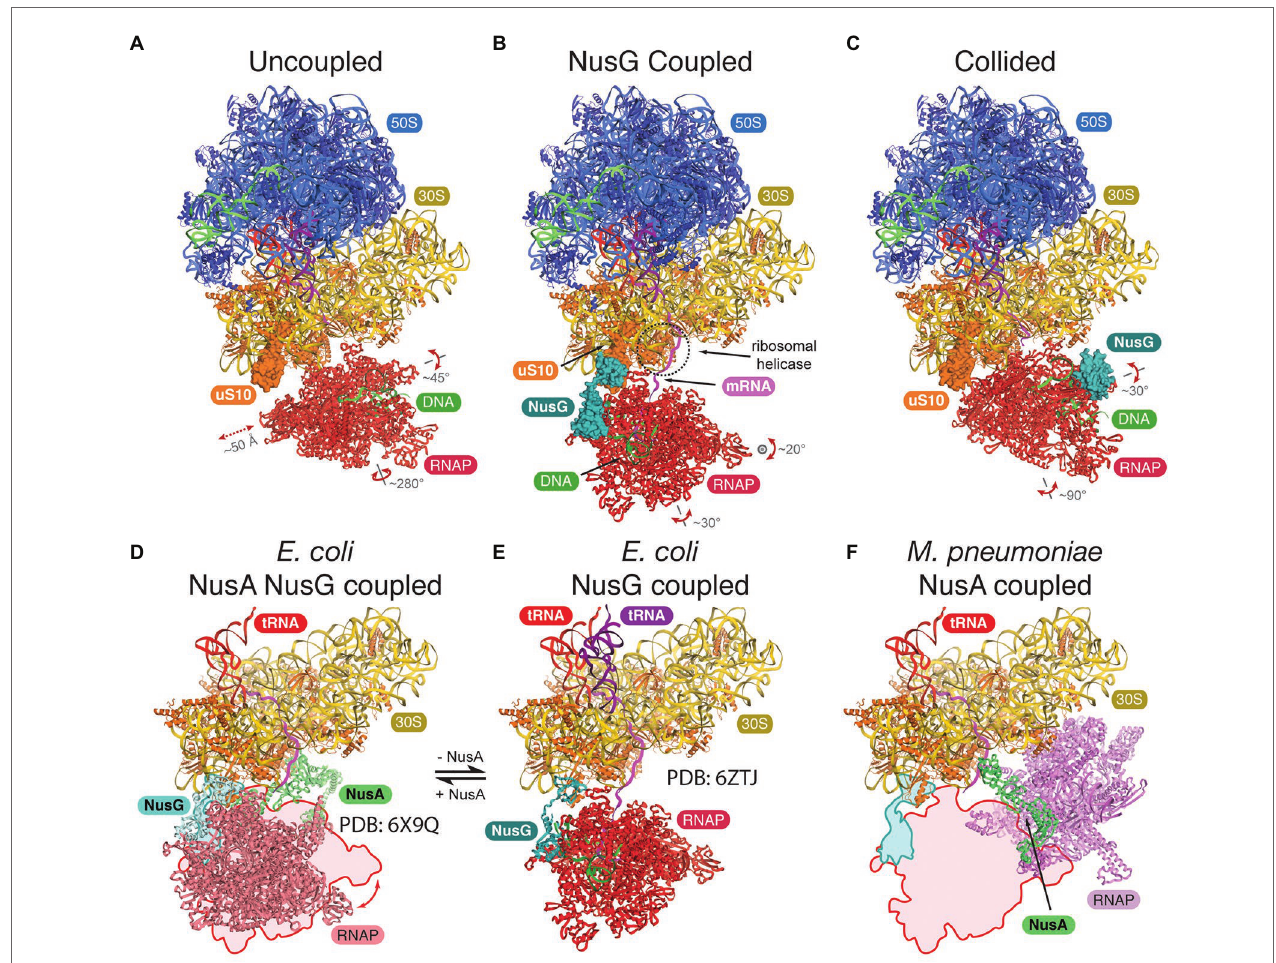
FIGURE 1 | Structures of the bacterial expressomes. (A) At mRNA spacings separating the RNA polymerase (RNAP) active site by more than ~35 nucleotides from the ribosomal P-site, and in absence of any coupling factor, RNAP adopts a wide range of orientations relative to the ribosome (uncoupled state; compare extent of translations and rotations). (B) Addition of the coupling factor NusG (turquoise) results in the formation of a physical link between RNAP and the ribosome (through uS10, orange) and restrains the rotational freedom. The emerging mRNA transcript (magenta) aligns with the ribosomal helicase (r-proteins uS3 and uS4, dashed circle; NusG coupled state). (C) Once the ribosome approaches RNAP further (mRNA spacings less than ~34 nucleotides), the expressome adopts a conformation similar to a previously observed collided state, where NusG can no longer form a physical bridge (collided state). (D–F) Comparison of transcription factor coupled states in Escherichia coli and Mycoplasma pneumoniae . The NusG-coupled state (E) gets stabilized by NusA in a similar relative orientation [ D , compare outline with model, differences are within rotational freedom indicated in panel (A) ]. In contrast, the NusA-coupled state observed in M. pneumoniae requires a major change in position and orientation of RNAP (F) , compare outline and model, E. coli RNAP and ribosome were docked into deposited cryo-electron tomography (cryo-ET) map (O’Reilly et al.,